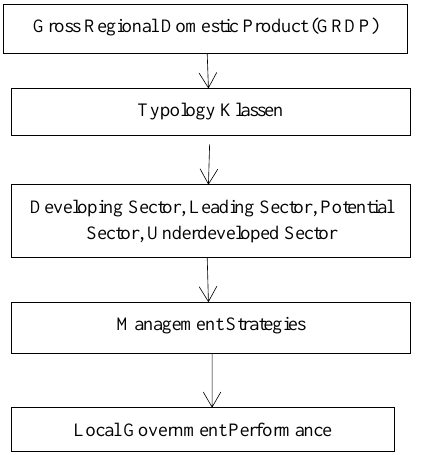
Figure 1: Research Framework. Source: